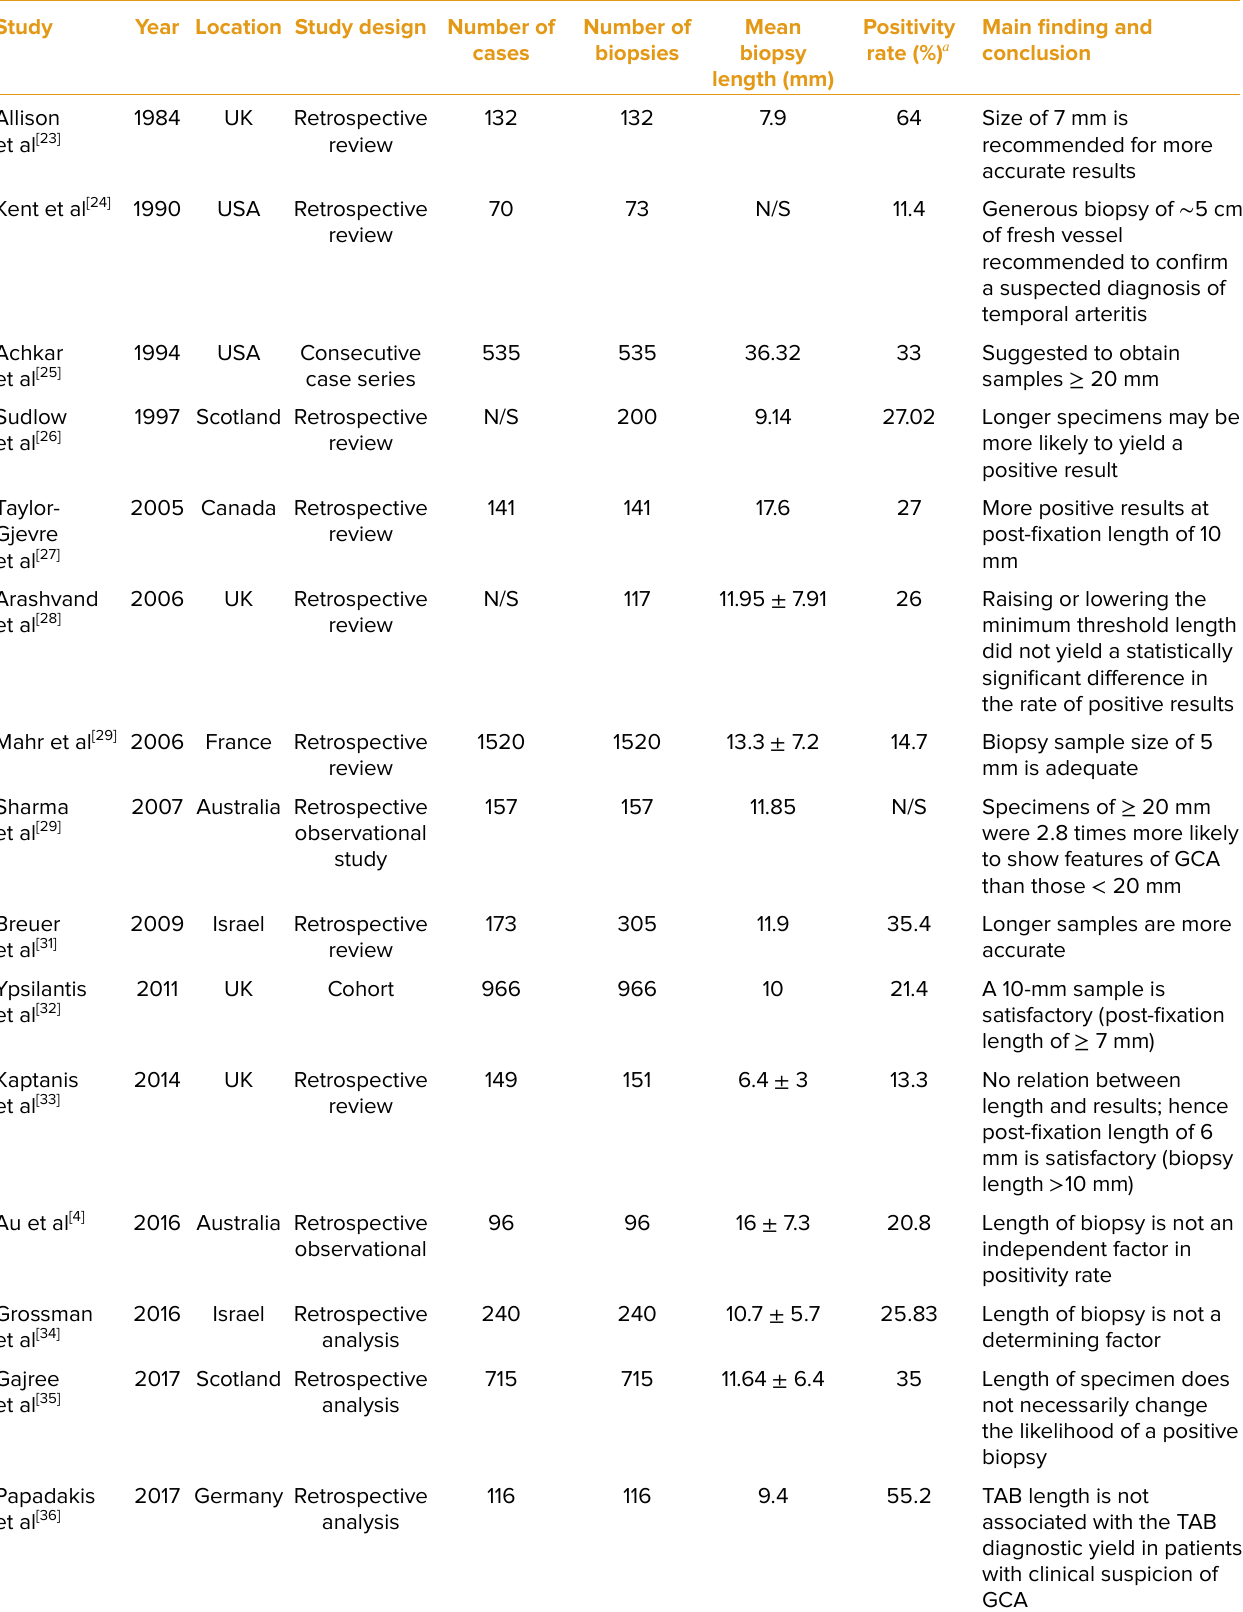
Table 4. Previous studies on the length of superficial temporal artery biopsy (STAB)